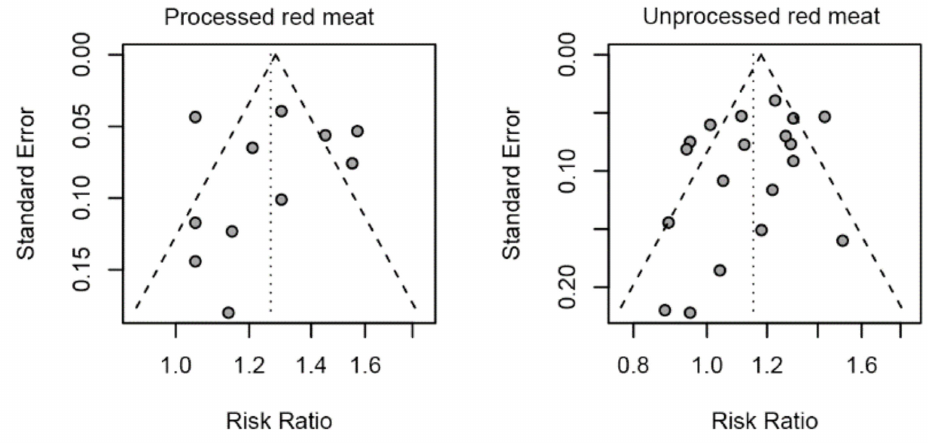
Figure 3. Funnel plot for association of TRM, PRM, URM with risk of